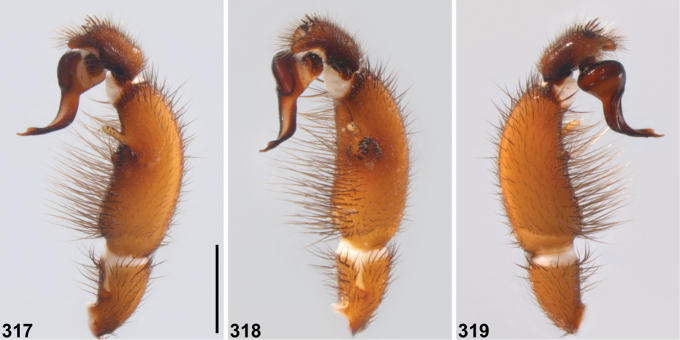

Idiosoma
mcnamarai sp. n., male holotype (WAM T26107) from Trayning (Western Australia; AVW), pedipalp. 317 Retrolateral view 318 Retroventral view 319 Prolateral view. Scale bar 2.0.